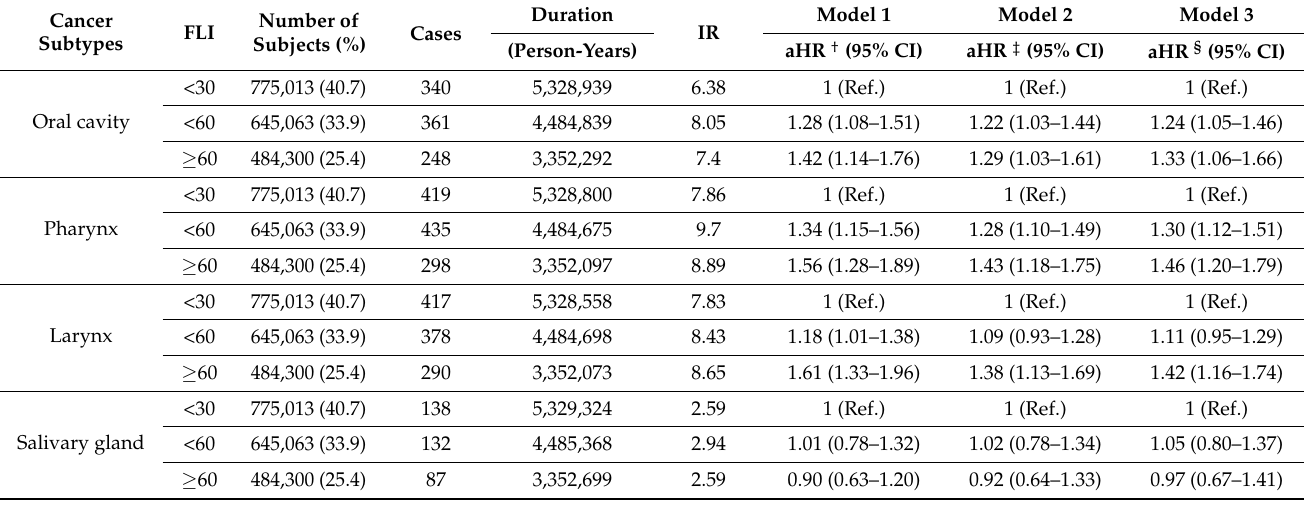
Table 2. Association between fatty liver and risk of HNC in DM patients.